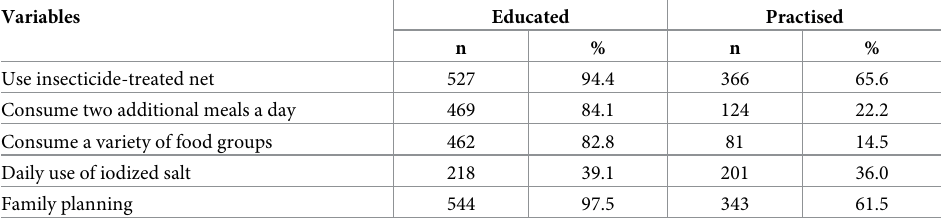
Table 2. Maternal practice of essential nutrition actions during lactation in three districts of Jimma Zone, South- west Ethiopia.